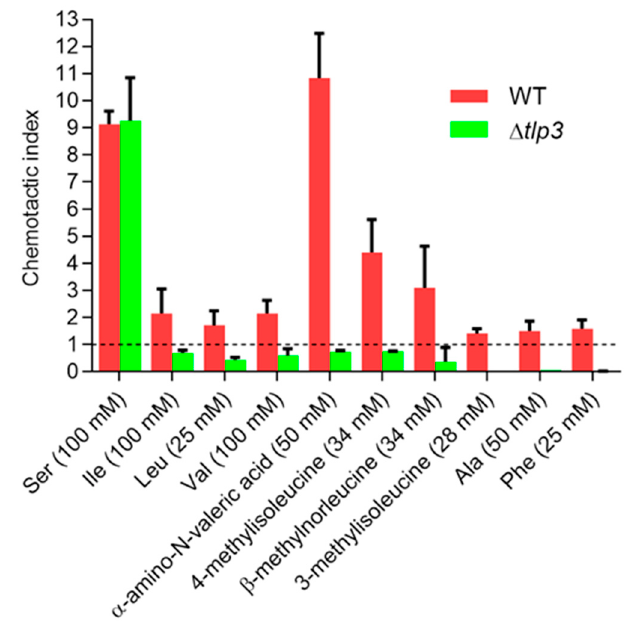
Figure 4. L-isoleucine analogues, L-alanine and L-phenylalanine elicit Tlp3-dependent attractant response in C. jejuni . Nutrient-depleted hard agar plug-based method was used. Values in the parentheses along the X-axis indicates the ligand concentrations used in the preparation of plugs; they are not identical as the standard assay concentration of 100 mM [62] could not be achieved for all ligands due to their solubility limit. L-serine and L-isoleucine were used as known Tlp3-independent and Tlp3-dependent attractant response controls, respectively. Error bars represent the standard error of the mean for three independent experiments.